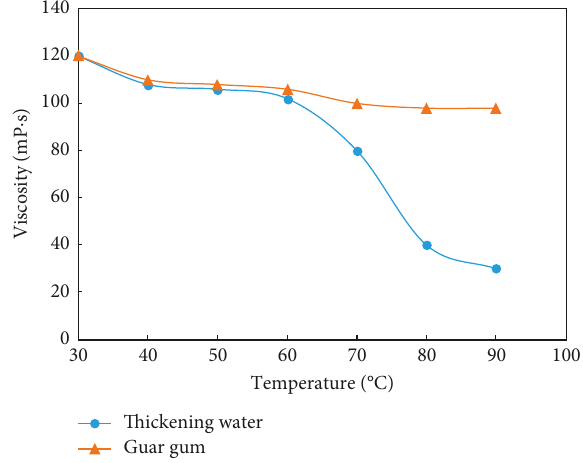
Figure 7: Comparison of viscosity changes with temperature: two kinds of fracturing